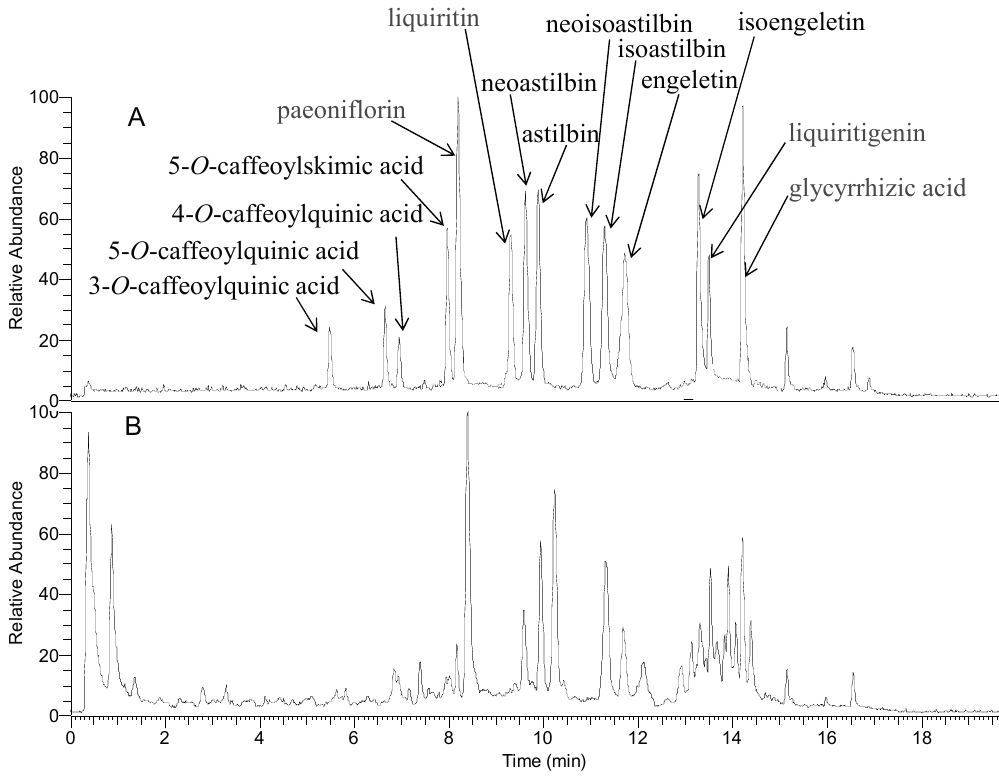
Figure 1. UHPLC-(-) ESI-MS total ion chromatograms of a mixture of fourteen standards ( A ) and PSORI-CM01 ( B